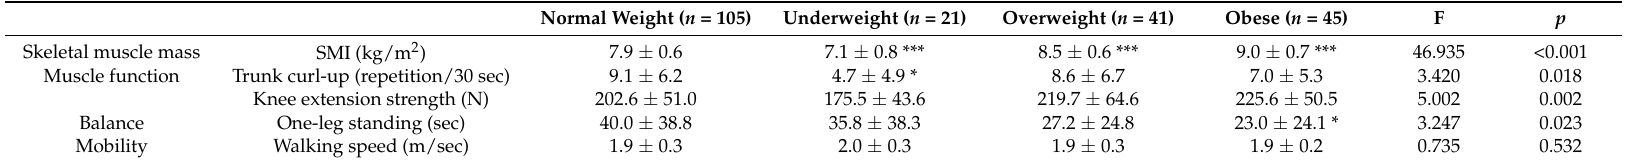
Table 2. Comparison of physical characteristics between the normal-weight group and the underweight, overweight, and obese